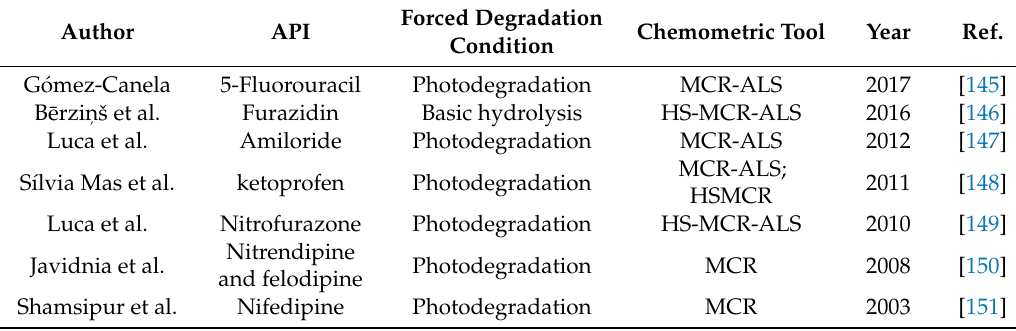
Table 9. Works involving forced degradation studies and the Multivariate Curve Resolution-Alternating Least Squares (MCR-ALS)